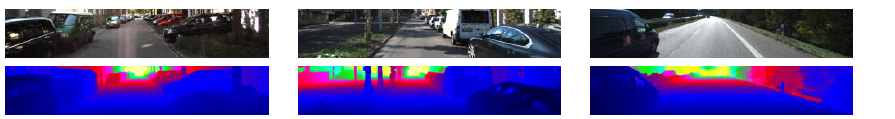
Figure 11. The qualitative results from [31] show the left RGB images from 3 scenes in the KITTI depth completion dataset in the top row and the corresponding depth map predictions in the bottom row are shown using colour to represent the depth